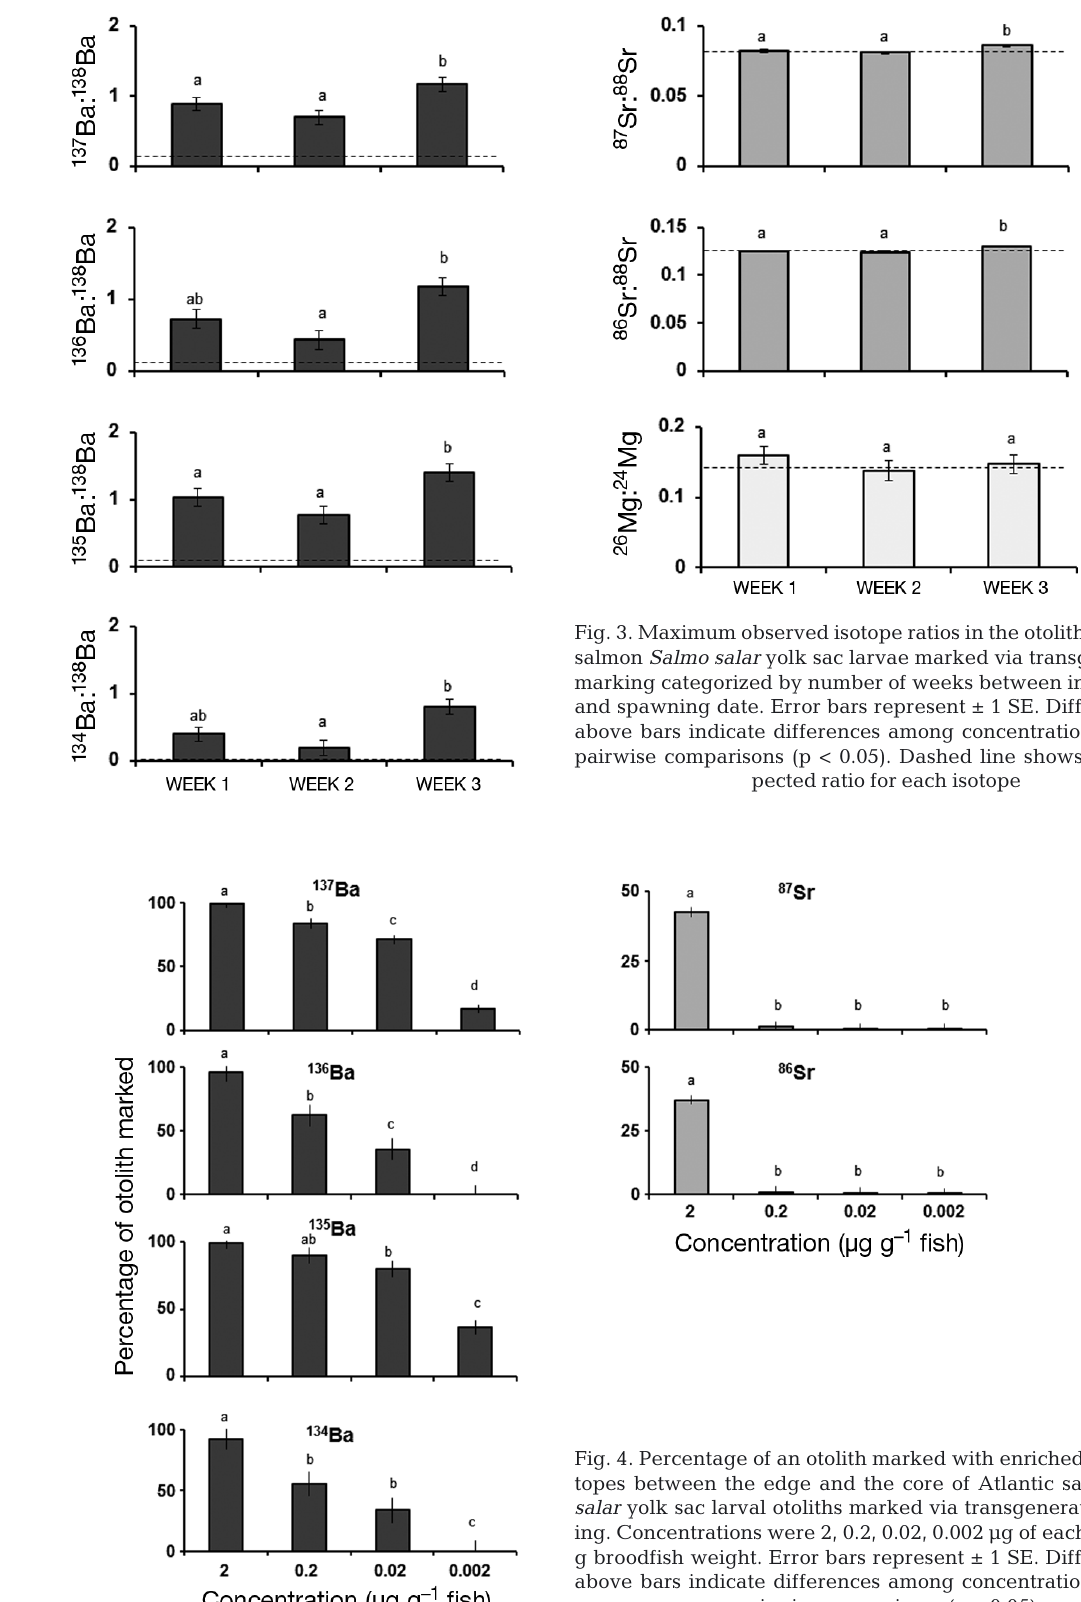
Fig. 4. Percentage of an otolith marked with enriched barium iso- topes between the edge and the core of Atlantic salmon Salmo salar yolk sac larval otoliths marked via transgenerational mark- ing. Concentrations were 2, 0.2, 0.02, 0.002 µg of each isotope per g broodfish weight. Error bars represent ± 1 SE. Different letters above bars indicate differences among concentrations based on pairwise comparisons (p <